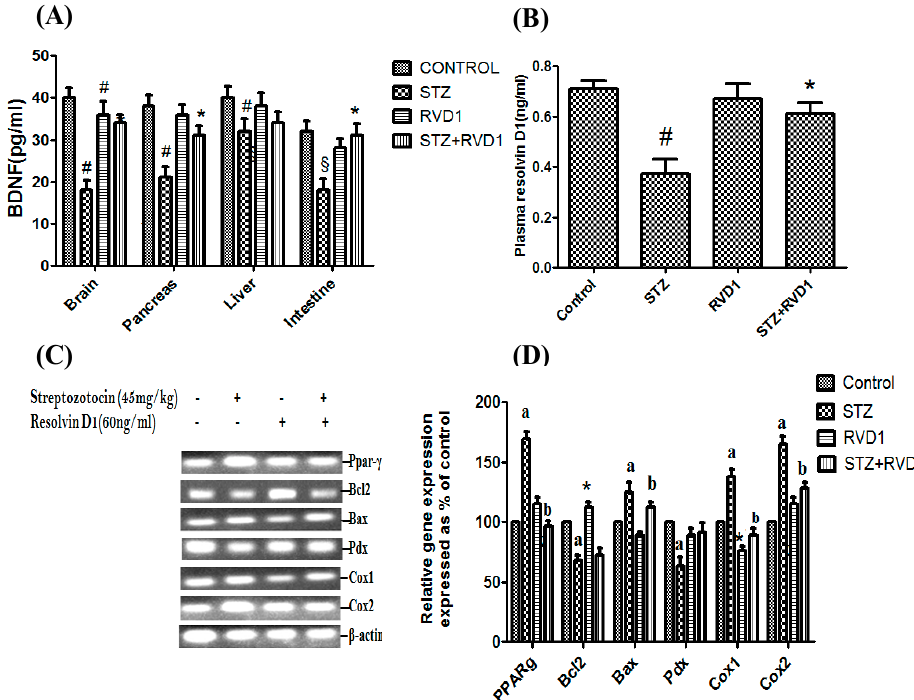
Figure 2. Effect of RVD1 treatment on levels of brain-derived neurotrophic factor (BDNF), plasma RVD1, and gene expression studies by semi-quantitative PCR. ( A ) Relative BDNF protein expression of brain, pancreas, liver, and the intestine of T1DM and control. Data are expressed as mean ± SEM. Brain: control vst1DM: # p ≤ 0.01, * p ≤ 0.05; Pancreas: control vs. T1DM: § p ≤ 0.01; Intestine: control vs. T1DM: # p ≤ 0.05. ( B ) Measurement of RVD1 levels in various groups measured at the end of the study (day 30). * p ≤ 0.001 compared to untreated control and # p ≤ 0.05 compared to STZ (T1DM) control. ( C , D ) Effect of RVD1 (60 ng/kg) treatment on changes in the mRNA expression of PPAR-gamma , Bcl2 ; Bax ; Pdx ; Cox1 , and Cox2 in pancreatic tissue. Pancreatic tissue was collected on day 30. The percentage of change in gene expression and β -actin studied by the semi-quantitative PCR method. The equality of sample loading was confirmed by β -actin gene expression. All the above set of experiments were done on two separate occasions, each time in triplicate ( n = 6), and all values expressed as mean ± SEM. a p ≤ 0.01, * p ≤ 0.05 compared to untreated control values and b p ≤ 0.001 compared to STZ (T1DM)